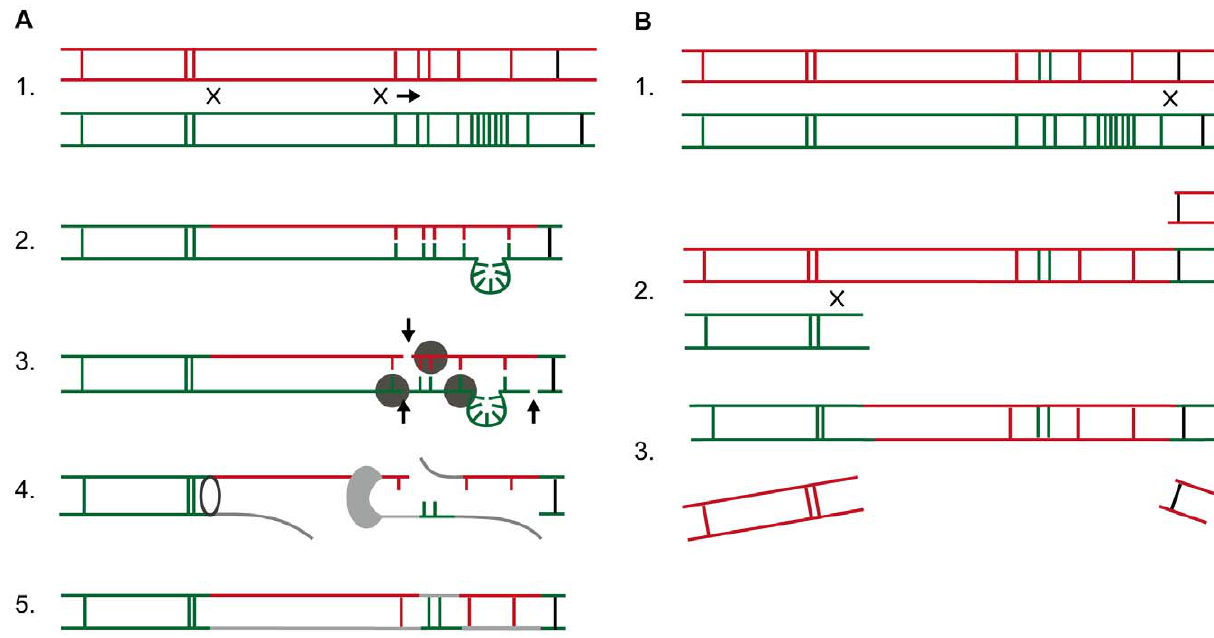
Figure 4. Two possible molecular mechanisms resulting in formation of the mosaic structure of the TPAMA_0326 locus. Green lines are nucleotide sequences specific for TPA strains (Nichols, SS14, Chicago), red ones for TPE strains (CDC-2, Gauthier, Samoa D). Vertical black lines denote corresponding positions of the TPAMA_0326 loci. A) Homologous recombination. 1. Homologous recombination between TPA and TPE loci with suggested possible recombination sites (x); arrow indicates direction of branch migration. 2. The resulting heteroduplex contains both TPA and TPE sequences; green loop denotes a 15 bp insertion present in all investigated TPA strains. 3. Recognition of mismatched DNA by MutS-MutL complex and subsequent cleavage of DNA strands by endonucleases (marked by arrows). 4. Unwinding of cleaved strands by DNA helicase (open elipse) and DNA polymerase-mediated (grey) gap filling. 5. Reparation of DNA breaks with DNA ligase. Alternatively, there is a possibility of an active DNA uptake across the cell membrane. Although no gene orthologs involved in natural competence have been identified in the TPA genomes, one cannot exclude this activity in one or several genes with unknown function. B) Gene conversion. Successive half crossing-over model. 1. First half crossing-over with suggested recombination site (x). 2. Successive second half crossing-over and the second recombination site (x). 3. Duplex recovery and degradation of both displaced ends. Please note that model B) requires the presence of two TPA-like nucleotide sequences in the donor TPE